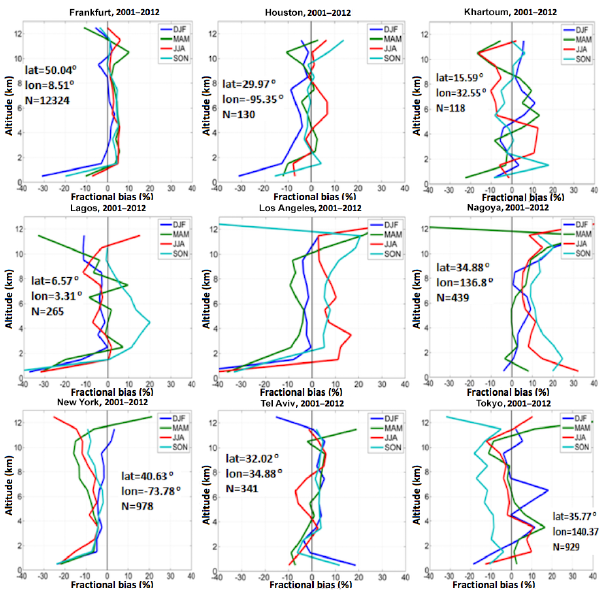
Figure 6. Seasonal mean relative biases [2(Clim- MOZAIC) / (Clim + MOZAIC)], expressed in percent, between trajectory-mapped and MOZAIC-IAGOS in situ profiles for the period from 2001 to 2012. The selected airports are representative of different meteorological and source conditions across the globe. N, lat, and lon are the number of profiles, latitude, and longitude of each airport.